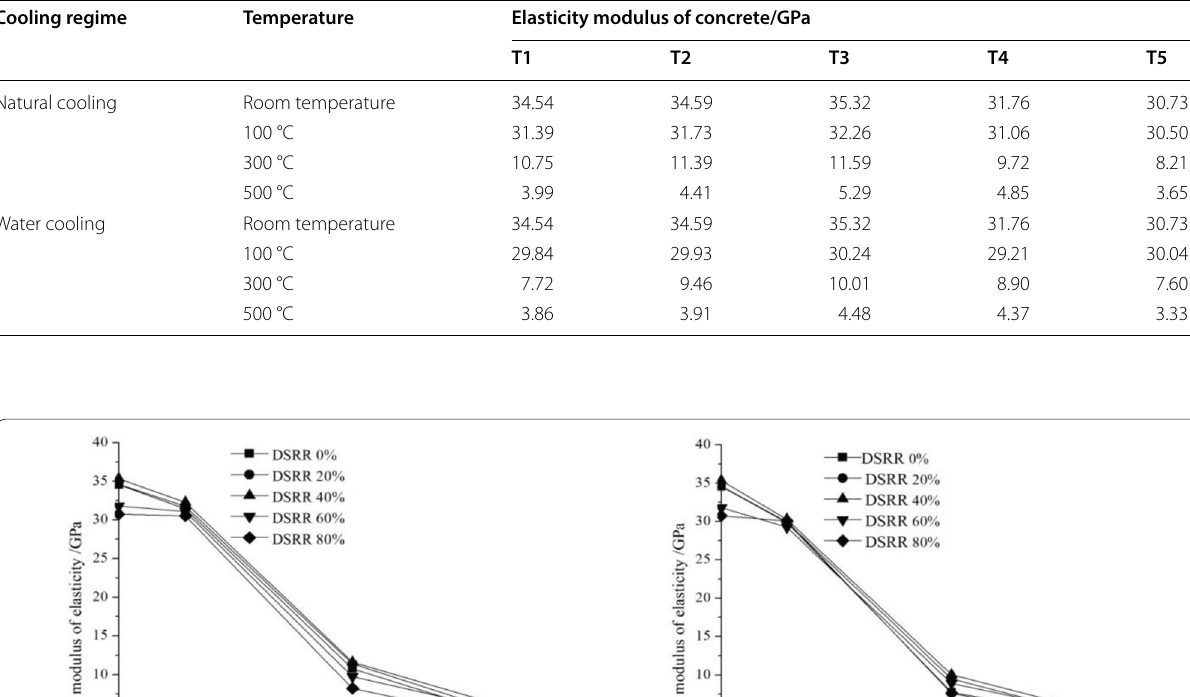
Table 5 Elasticity modulus of concrete produced with desert sand after elevated temperature. Cooling regime